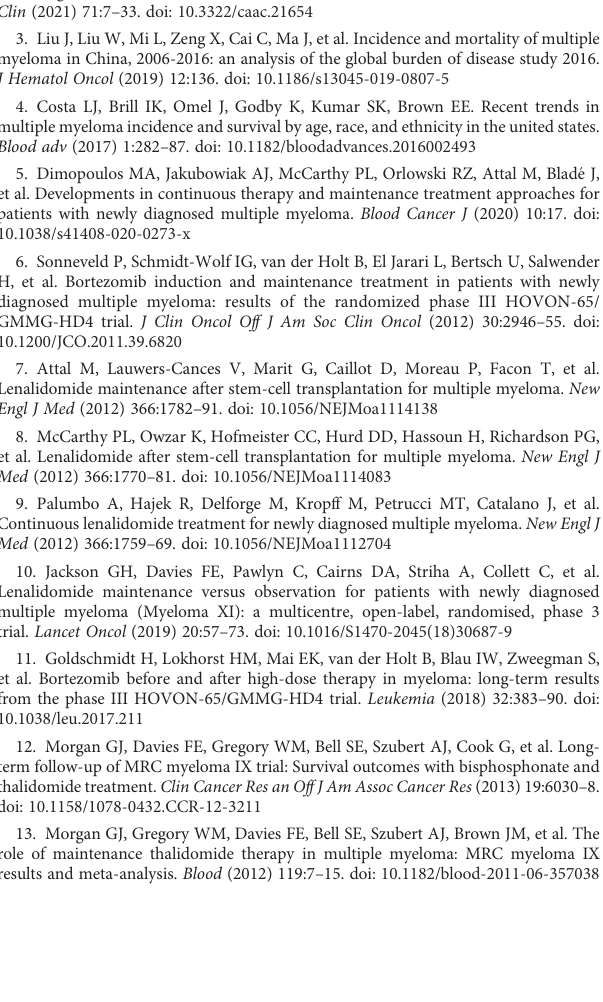
medianOSof patientswith 17pdeletion(n=6) versusthosewithout(n=102) in patients on thalidomide maintenance. SUPPLEMENTARY FIGURE 4 Impact of high-risk IgH translocation on progression-free survival (PFS) and overall survival(OS)oflenalidomide, bortezomibandthalidomidemaintenance. (A, B) The median PFS and median OS of patients with t(4,14) or t(14,16) (n=15) versus those without (n=76) in patients on lenalidomide maintenance. (C, D) The median PFS and median OSof patients with t(4,14) or t(14,16) (n=15) versus those without (n=49) in patients on bortezomib